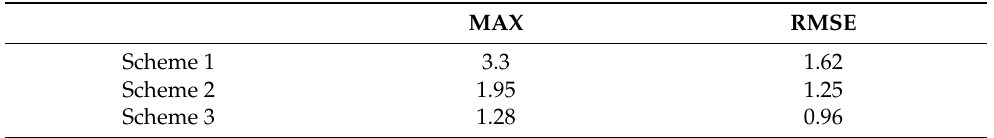
Table 5. Elevation error (m) obtained by different